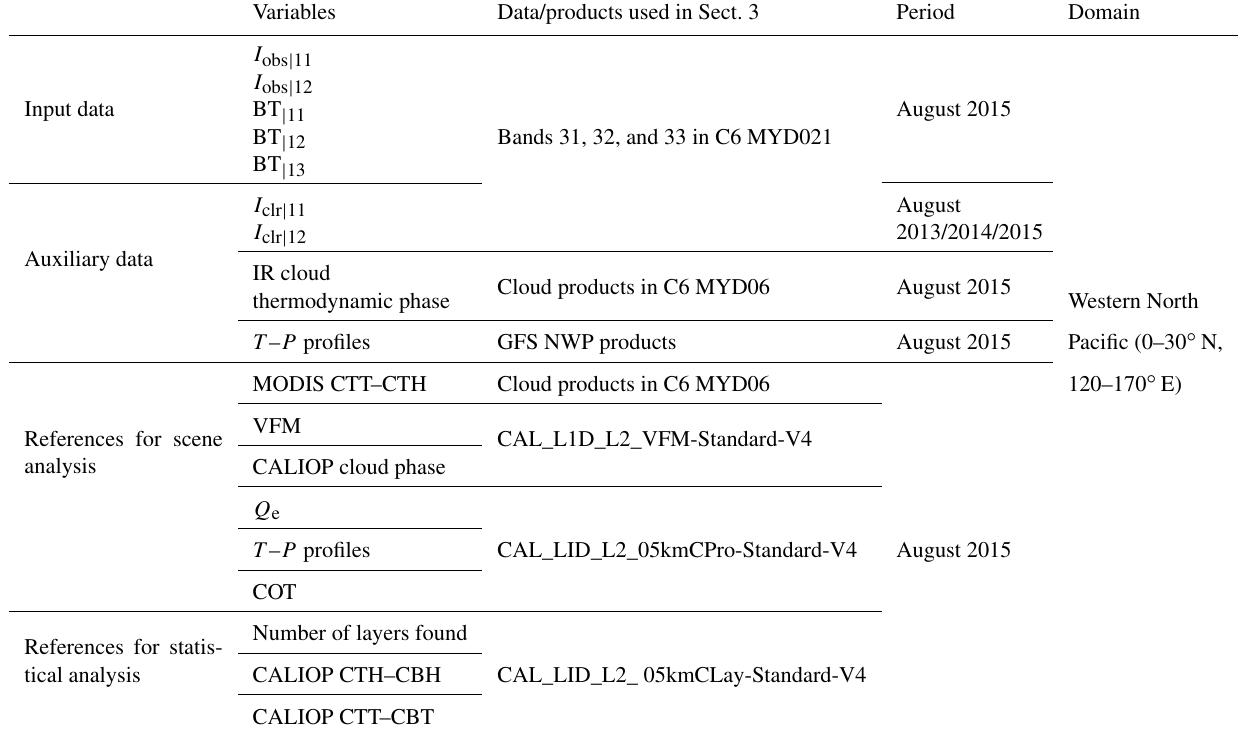
Table 3. Data used for the tests shown in Fig. 3. Input and auxiliary data are taken from the MODIS C6 cloud products and from CALIOP v4 cloud products. The abbreviations CTT–CBT, CTH–CBH, COT, T – P , and VFM refer to cloud-top and cloud-base temperature, cloud-top and cloud-base height, cloud optical thickness, temperature and pressure, and vertical feature mask. The vertical profile of the extinction coefficient at 532nm is denoted as the Q e